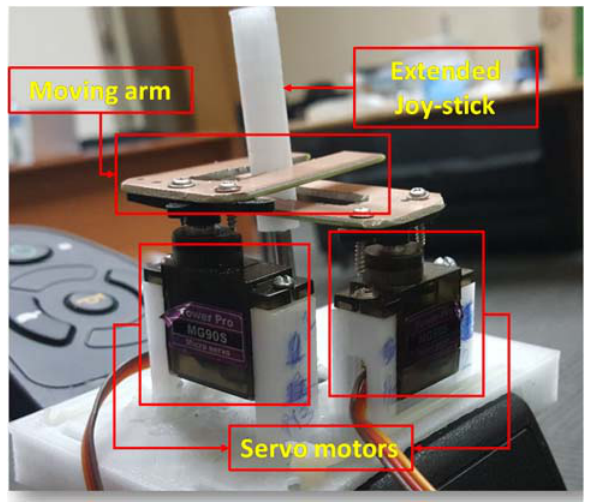
Figure 15. Two servo motors along with two moving arms were attached to original joystick with 3D printed support structure for motion control.